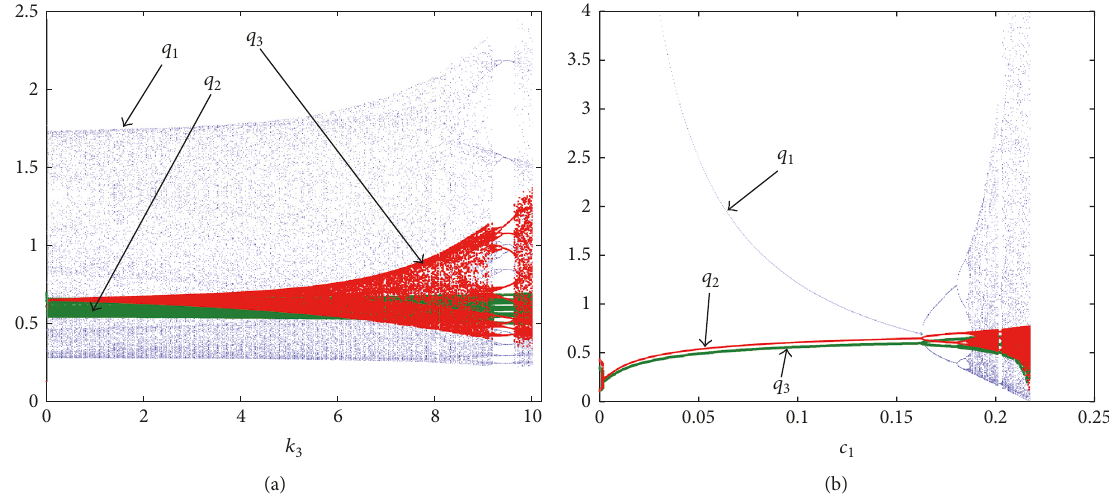
Figure 2: Bifurcation diagram for system (10) with respect to the parameter: (a) 𝑘 3 and the values of the other parameters are fixed, 𝑘 2 = 4 , 𝑘 = 5 , 𝑐 = 0.19 , 𝑐 = 0.18 , and 𝑐 3 1 2 𝑐 = 0.17 . 3